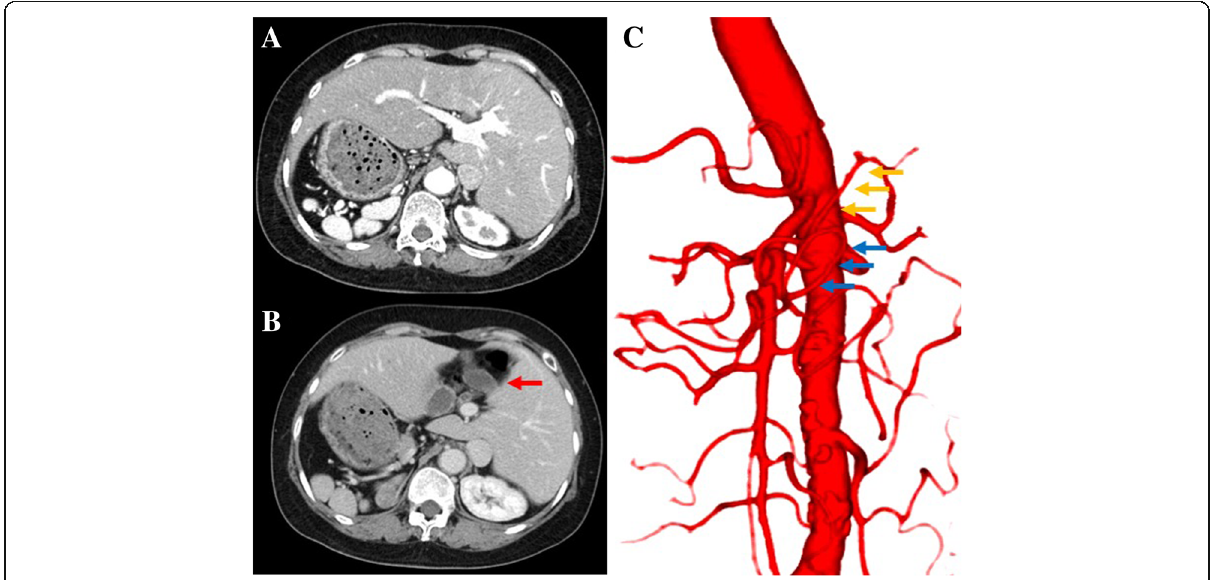
Fig. 1 Computed tomographic (CT) image, preoperative three-dimensional CT angiography. a , b CT images showing polysplenia and left-sided gallbladder ( red arrow ). c Three-dimensional CT angiography showing the common hepatic artery ( yellow arrows ) and right gastroepiploic artery ( blue arrows ) arising from the first jejunal